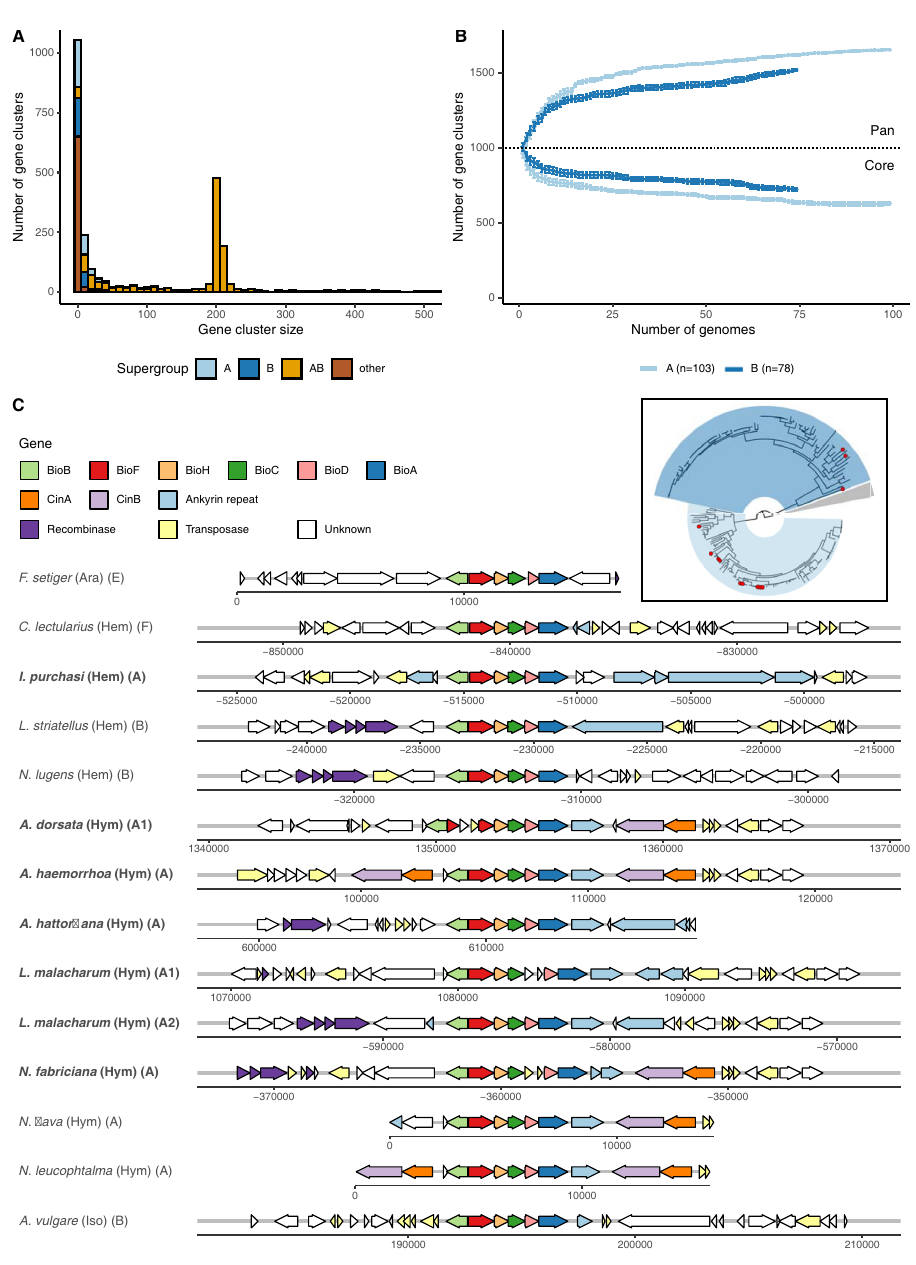
Fig 4. Exploration of Wolbachia protein-coding gene diversity. (A) Histogram of protein family size per supergroup. The data underlying this Figure can be found in S1 Data. (B) Rarefaction analysis of pan- and core proteomes of supergroups A and B, based on 500,000 random addition-order permutations of co-occurring orthogroups excluding novel genes. The data underlying this Figure can be found in S1 Data. (C) Synteny of the biotin cluster shows conserved gene order and punctuated pattern of species presence (inset, species with biotin cluster present are highlighted with red